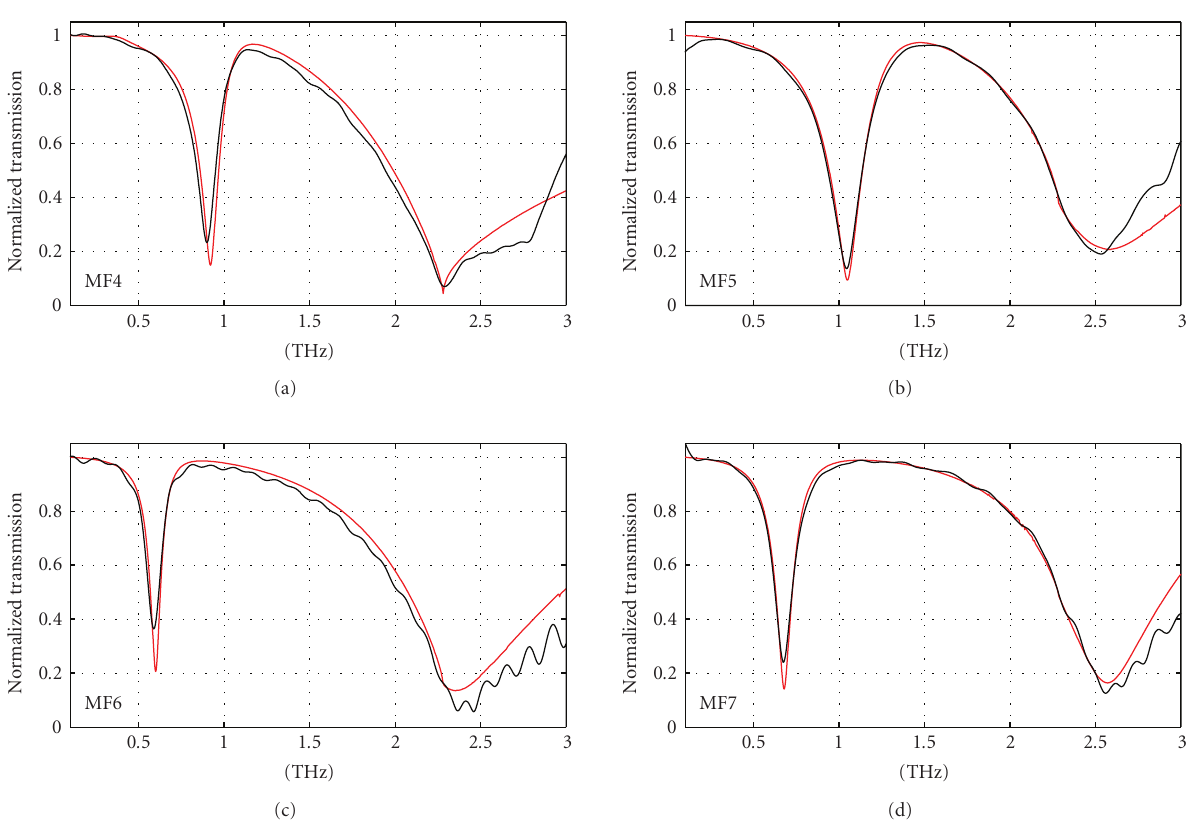
Figure 3: Normalized transmission through metafilm samples MF4, MF5, MF6, and MF7. Black curves indicate measured data while red curves show simulation